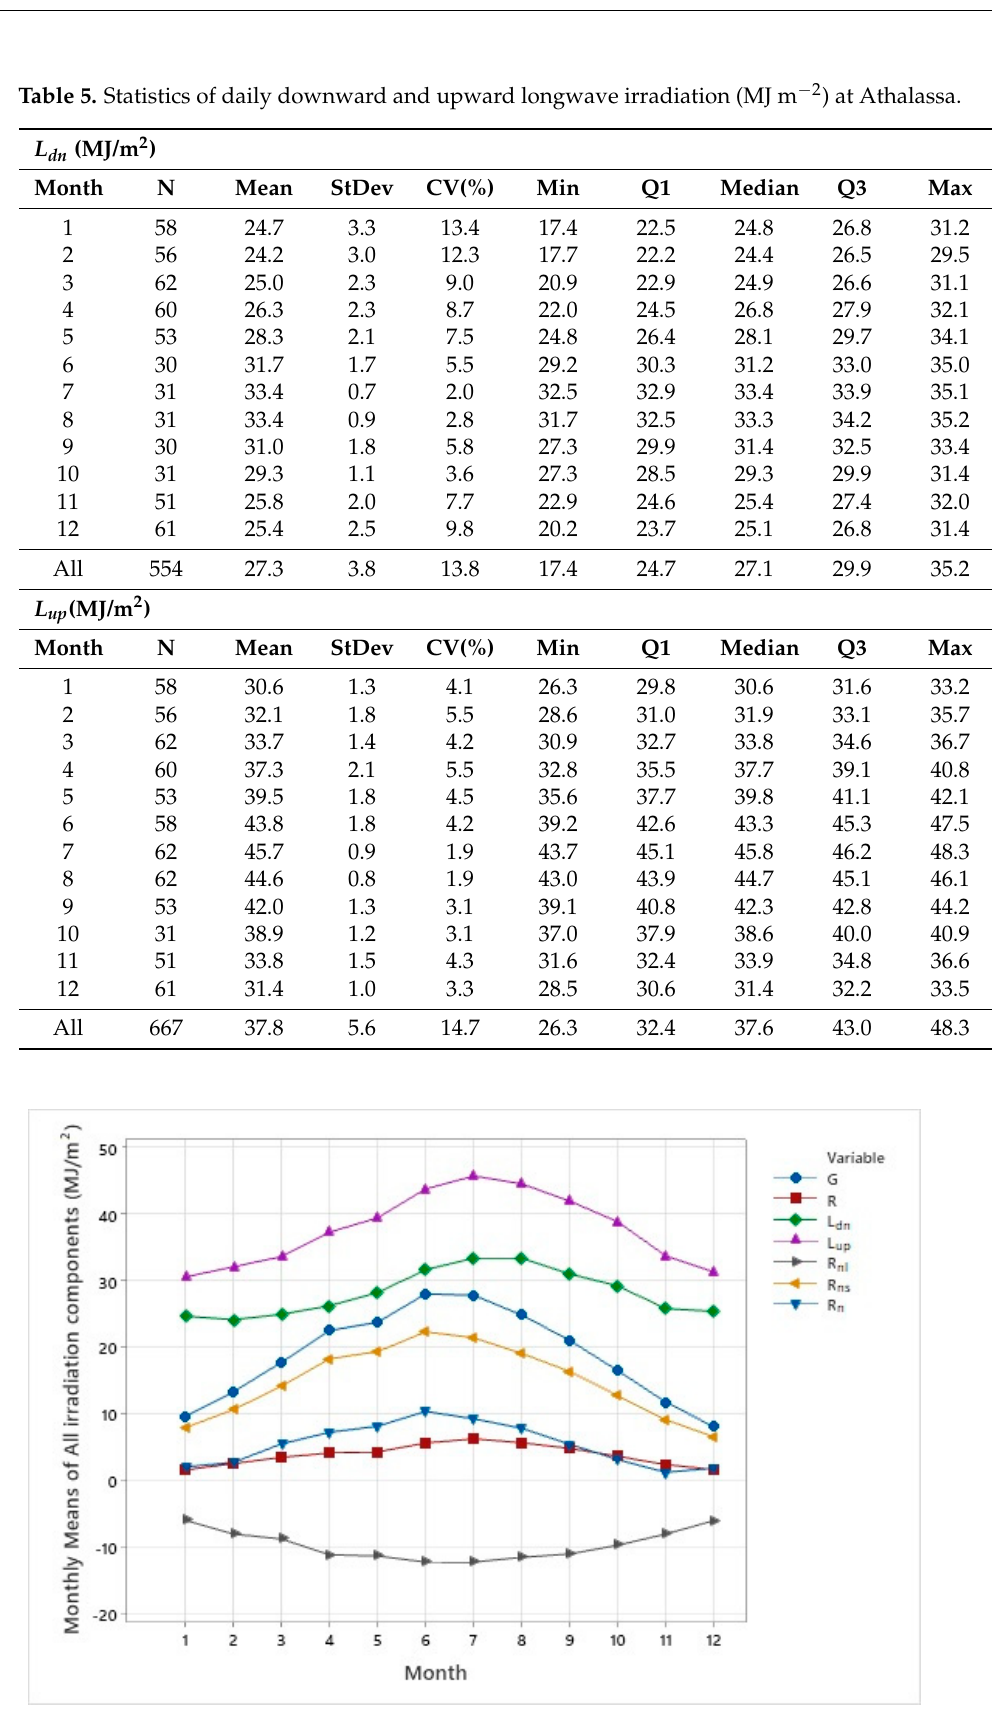
Figure 12. Monthly mean daily longwave and shortwave irradiation components.